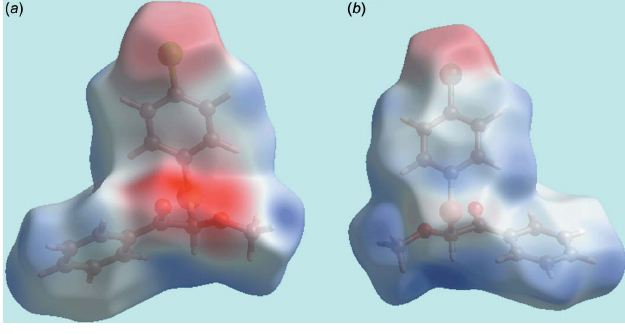
Figure 4 Two views of the Hirshfeld surfaces mapped over the electrostatic potential in the range (cid:5) 0.073 to + 0.056 au. The red and blue regions represent negative and positive electrostatic potentials, respectively.